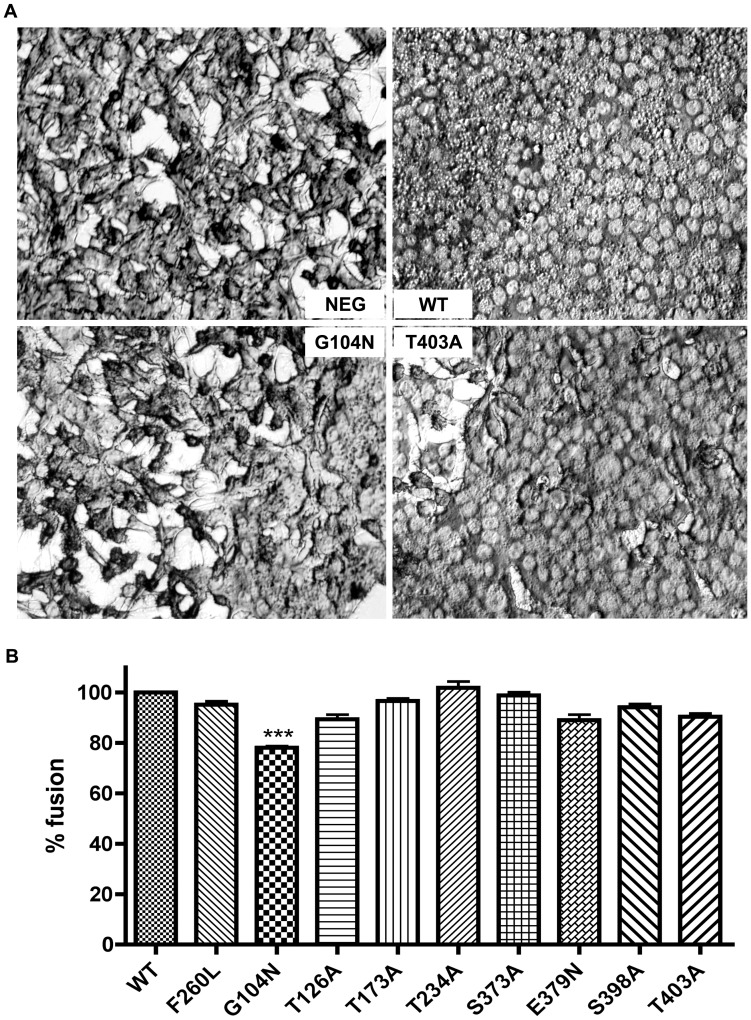
Addition of N-glycan in GP1 of LCM virus causes reduction in virus fusion.(A) DBT cells were infected at MOI 5 for 2 h then exposed to media pH 5 triggering fusion mediated by the glycoprotein. (B) Percentage of cells fused normalized to WT measured by microscopy using module object count from Nikon NIS software N = 10. Statistics analyzed by one-sample t test P<0.0001 compared to WT.